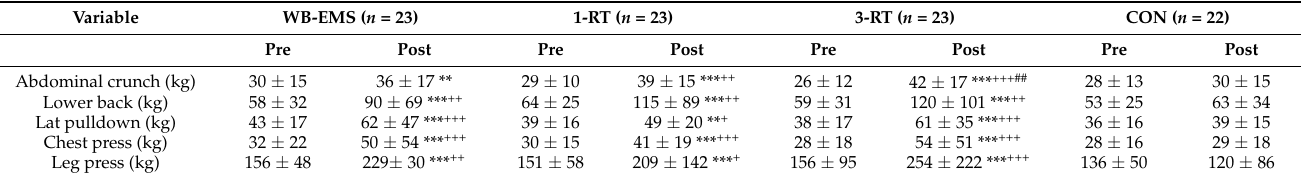
Table 5. Muscle strength pre- and post-intervention.